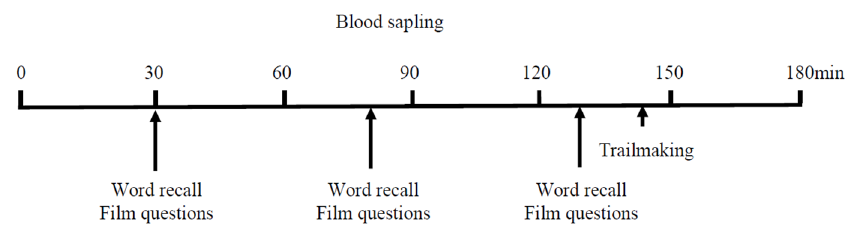
Figure 1. Timing of the blood sampling (0–180min) and cognitive test times relative to baseline (0 min).